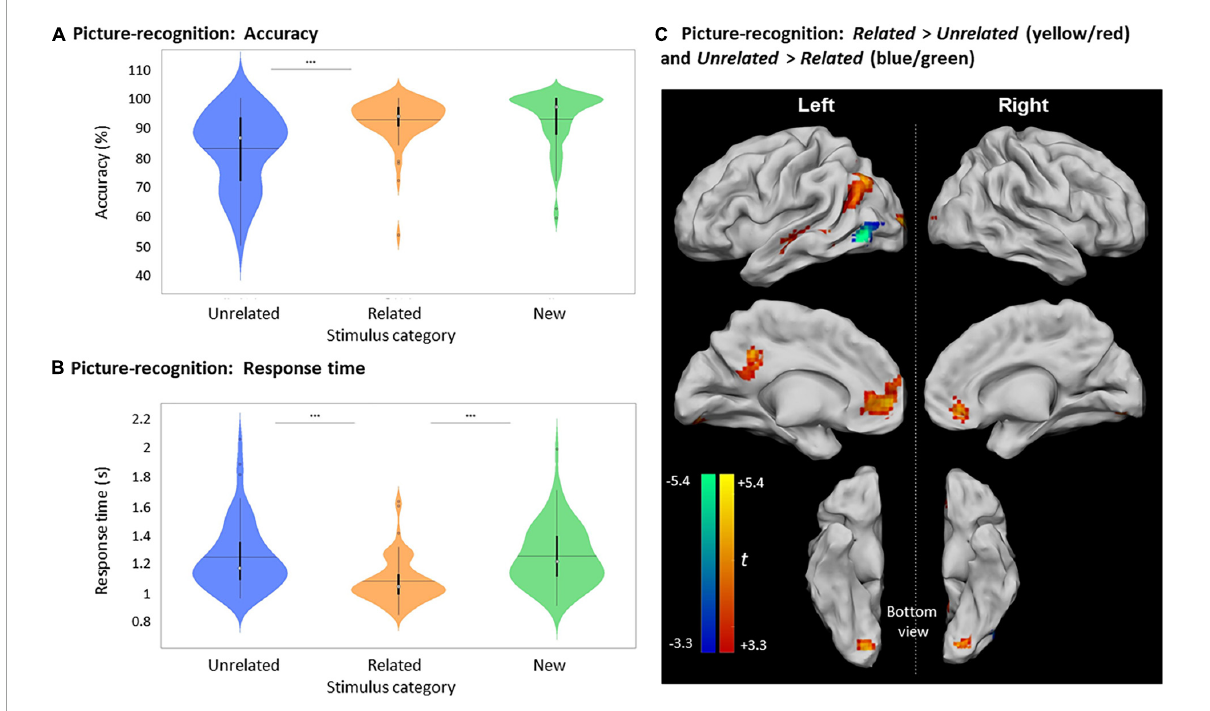
FIGURE4 Picture recognition based on relatedness during encoding. (A) Violin plots of recognition accuracy for New stimuli and Old stimuli, depending on their relatedness during encoding (i.e., Unrelated or Related ). [***: p < 0.001, horizontal black line indicates the mean, thick vertical black bars are a box plot, center white circles represent the median]. (B) Violin plots of response times for correct New and correct Old judgments depending on their relatedness during encoding [notations as in panel (A) ]. (C) Clusters with significant activity during recognition for Related > Unrelated (red scale) and for Unrelated > Related (blue scale), p < 0.05, FWE-cluster corrected, cluster-forming threshold = 84 voxels (at p < 0.001,